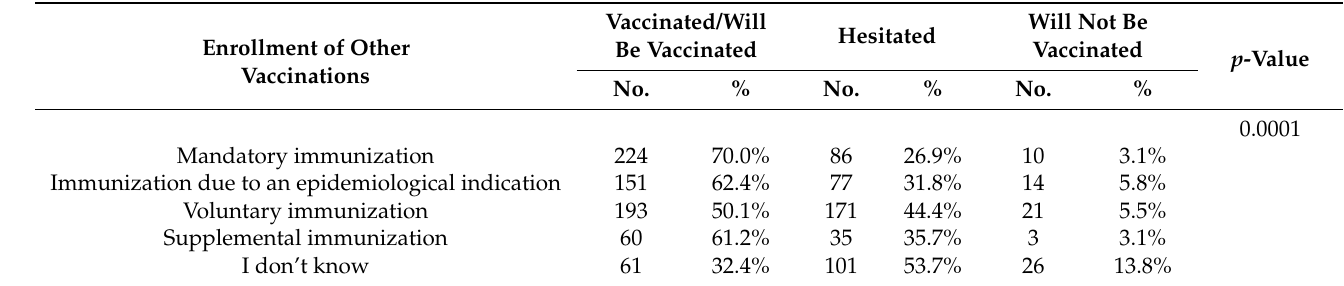
Table 3. Willingness to be vaccinated for COVID-19 by previous vaccination history.